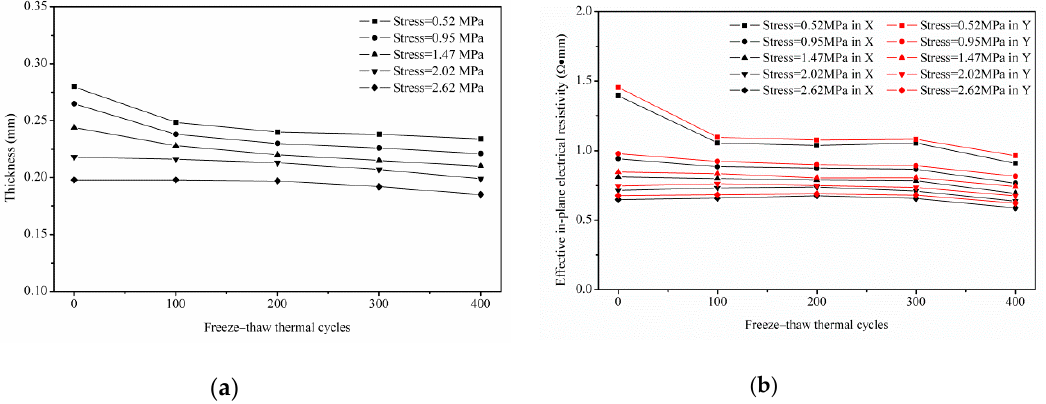
Figure 9. Degradation of pristine and aged GDLs: ( a ) Thickness vs. freeze–thaw thermal cycles; ( b )